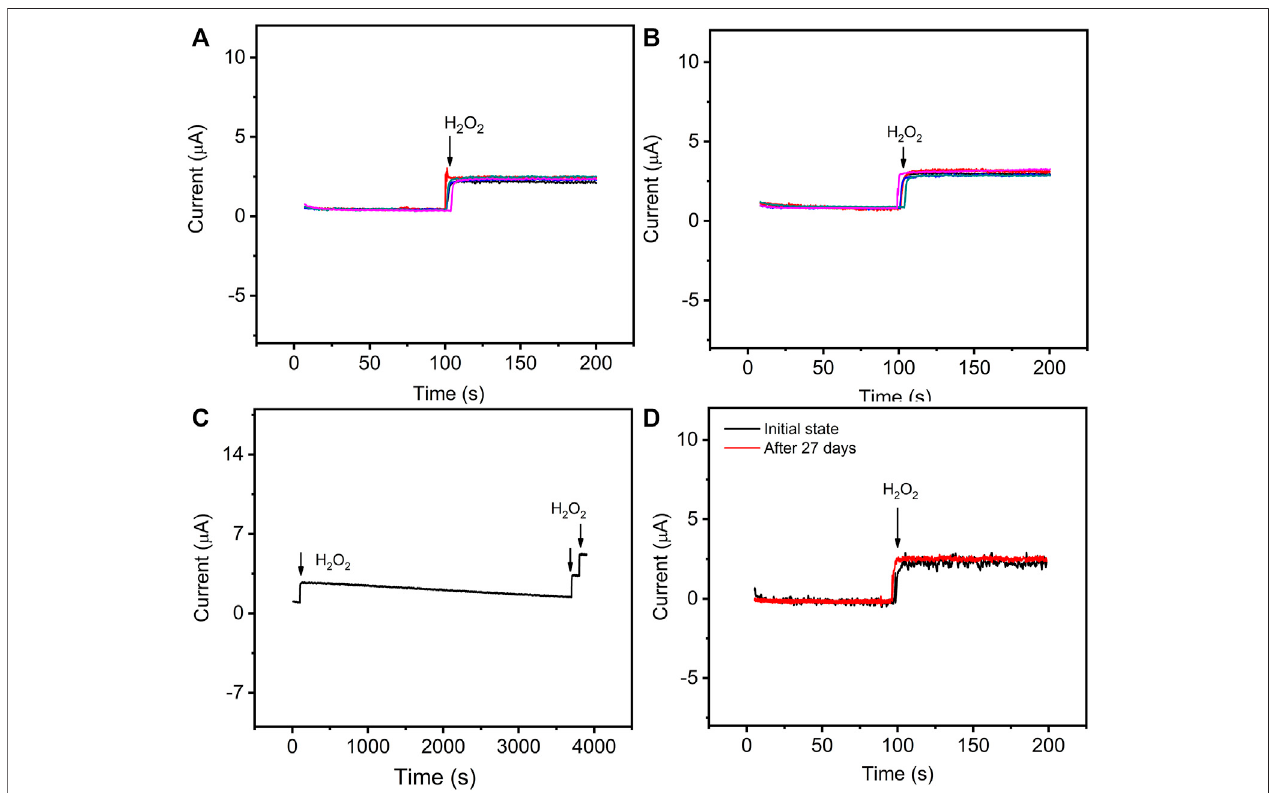
FIGURE6| Thecurrent – timecurvesofGO – NMB/GCEtoward83 μ MH 2 O 2 preparedwiththesameelectrodefor fi vetimes (A) and fi vedifferentelectrodes (B) . (C) SuccessivecurrentresponseoftheGO – NMB/GCEtoward83 μ MH 2 O 2 in0.1 MPBSbeforeandafter1-hresponse. (D) Long-termstoragestabilityofthesensorforthe response toward 83 μ M H 2 O 2 before and after 27